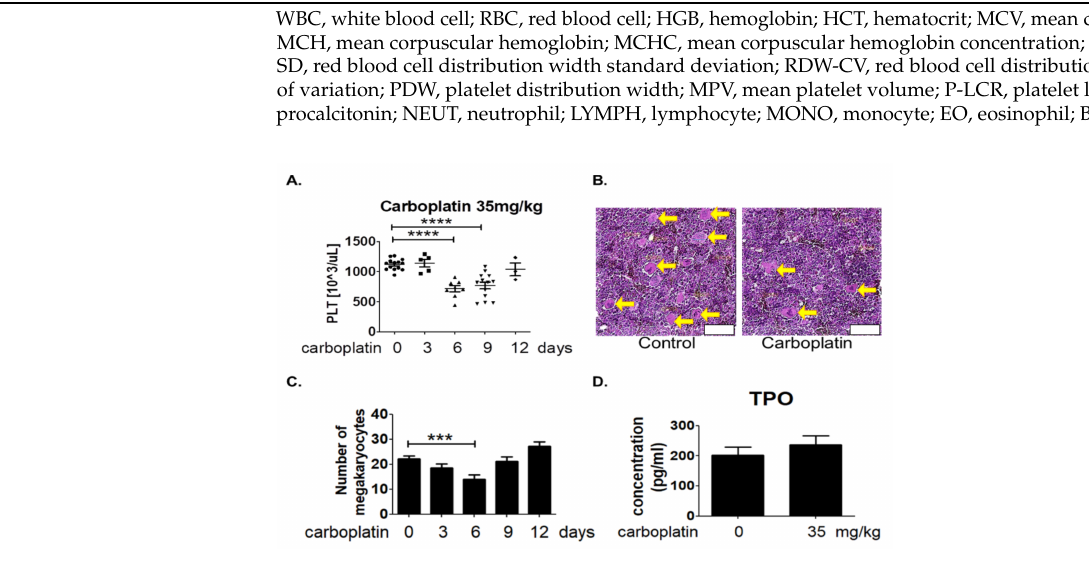
Figure 1. The time-dependent change of platelet counts in blood and megakaryocyte counts in bone marrow after carboplatin treatment. Rats were randomly divided into five groups (at least five rats in each group) and sacrificed at 0, 3, 6, 9, and 12 days after intraperitoneal injection of 35 mg/kg carboplatin. ( A ) The numbers of platelets in the blood were determined by blood analyzer at 0, 3, 6, 9 and 12 days after carboplatin treatment. ( B ) Photos shown were bone marrow sections prepared from control and carboplatin-treated rat at the sixth day. Megakaryocytes were identified based on their characteristic morphology such as large size, pink cytoplasm and lobated nucleus and indicated by the yellow arrows. Scale bar = 60 µ m. ( C ) Megakaryocyte were counted in the HE-stained sections of bone marrow at 0, 3, 6, 9, and 12 days after carboplatin treatment under microscopic examination by Nikon ECLIPSE Ni-U. ( D ) TPO concentrations in the blood prepared from control and carboplatin- treated rat at the sixth day were measured by ELISA. (*** p -value < 0.001, **** p -value < 0.0001, three independent experiments were